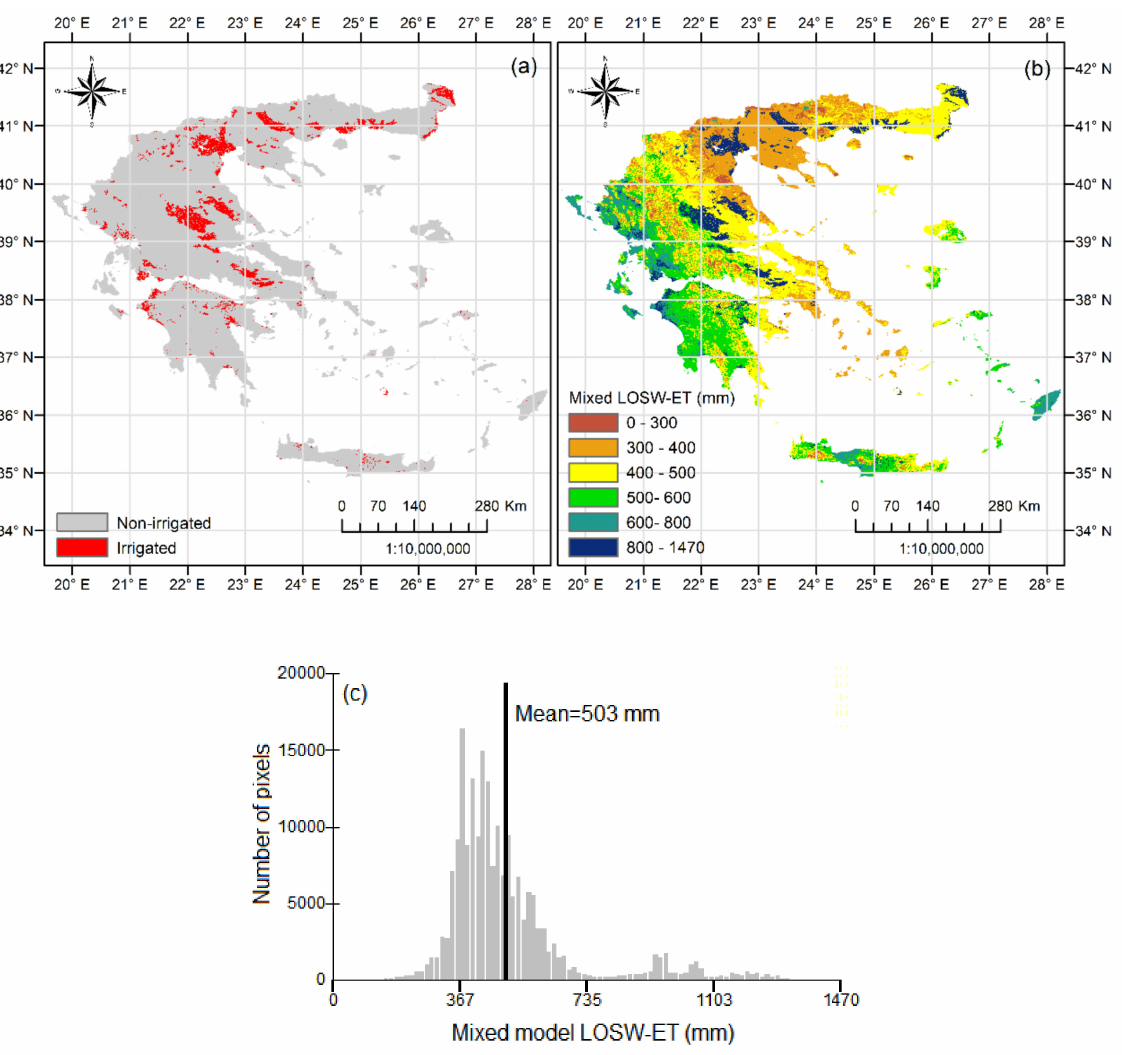
Figure 9. ( a ) Irrigated and nonirrigated lands in Greece according to CORINE 2018; ( b ) Mean annual actual evapotranspira- tion in Greece for the period 1950–2000 according to the mixed LOSW-ET concept; ( c ) Frequency histograms of mean annual actual evapotranspiration of mixed LOSW-ET based on the pixel values of the respective raster dataset of Figure